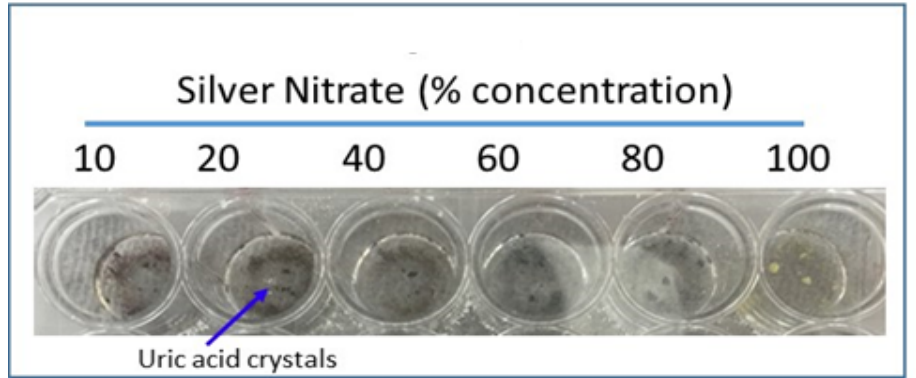
Figure 2. Reduction of silver nitrate solution of increasing concentrations by crystallized urate. Urate crystals were added to 200 µL solutions of increasing concentration of silver nitrate; 20% silver nitrate solution demonstrated most effective staining.